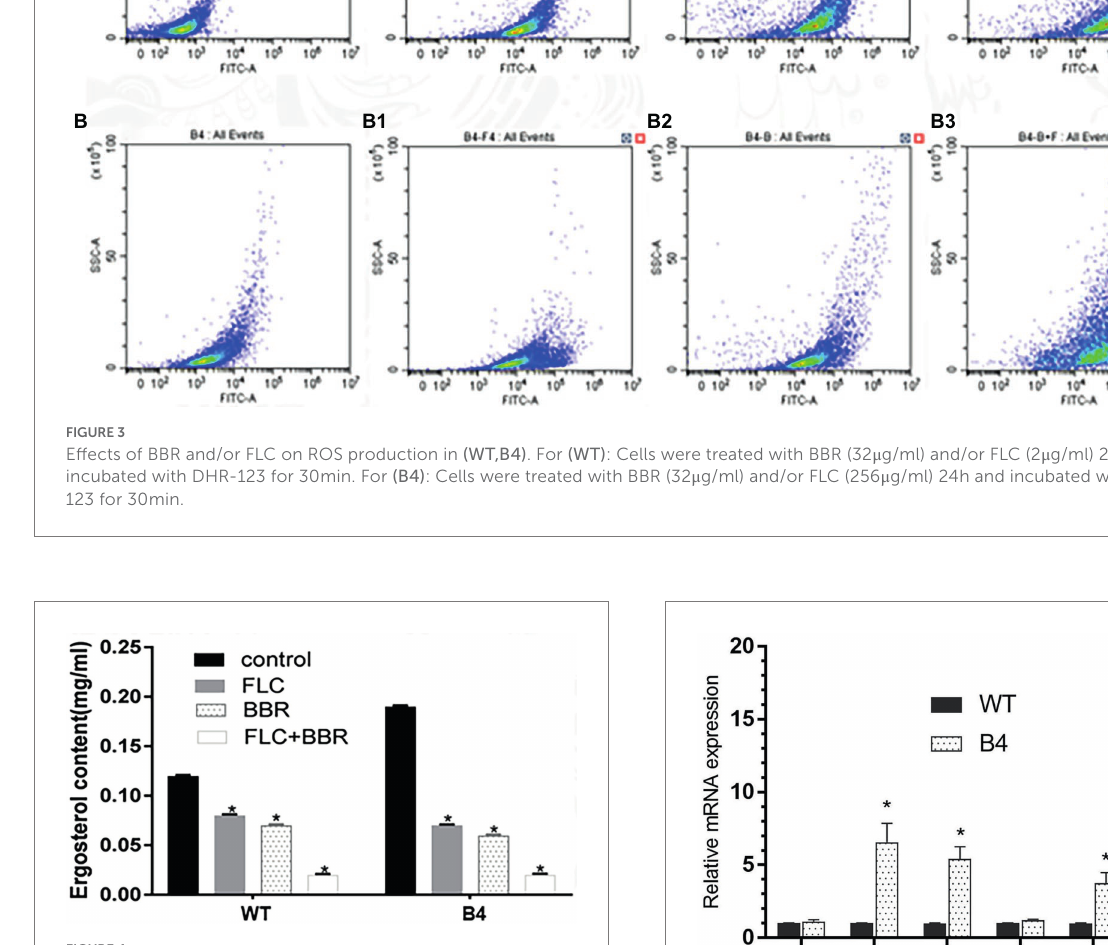
FIGURE 4 Ergosterol content surveyed by HPLC after the administrations of agents in WT and B4. * p < 0.05 compared with the control. FIGURE 5